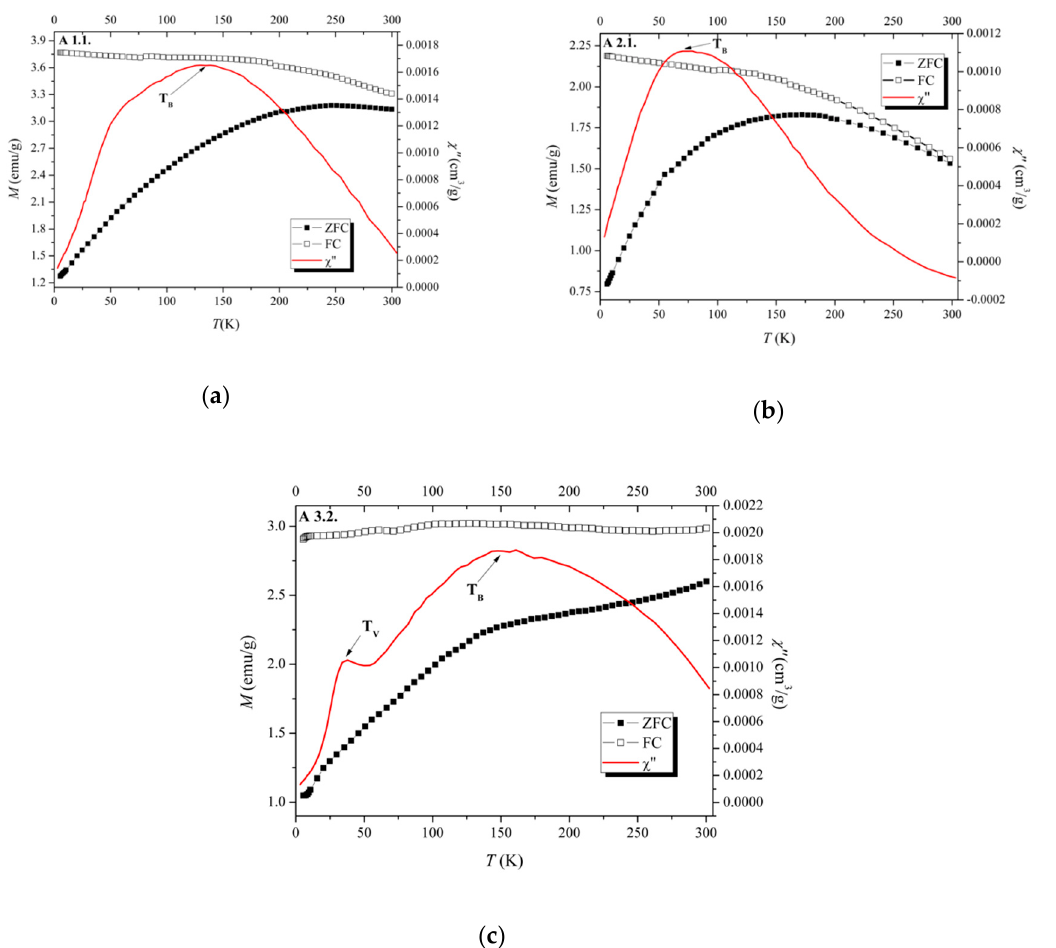
Figure 6. Temperature dependence of magnetization (ZFC / FC curves at 25 G) and AC susceptibility (out-of-phase component χ ” at 995 Hz) of naked SPIONs: ( a ) A 1.1, ( b ) A 2.1, ( c ) A 3.2.